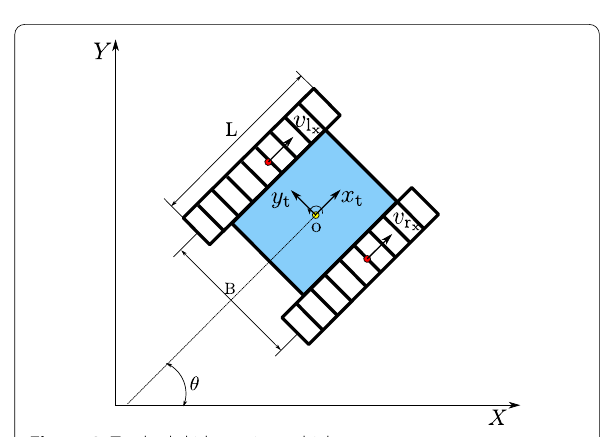
Figure 3 Tracked skid-steering